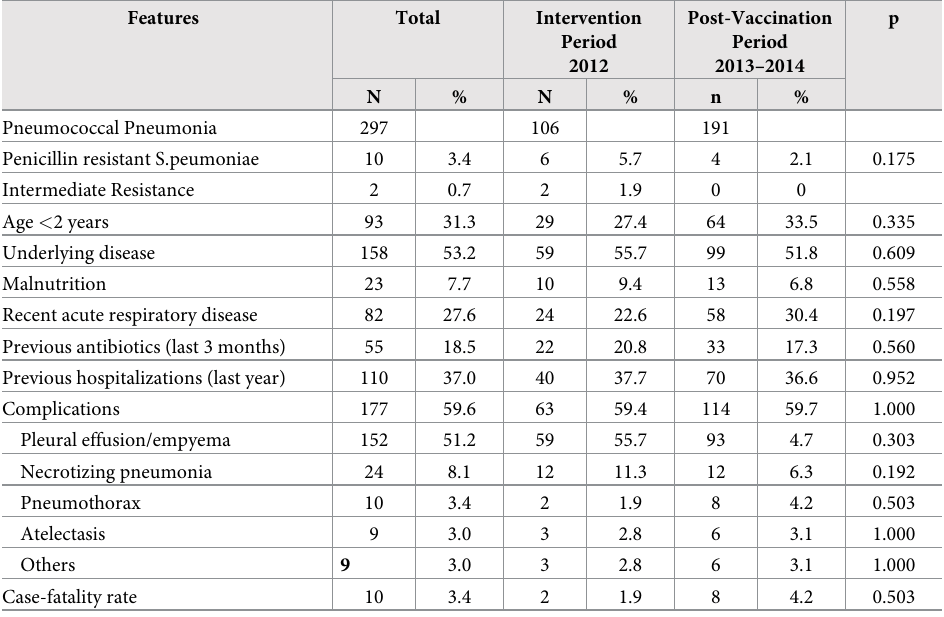
Table 3. Pneumococcal pneumonia cases features after PCV13 vaccine